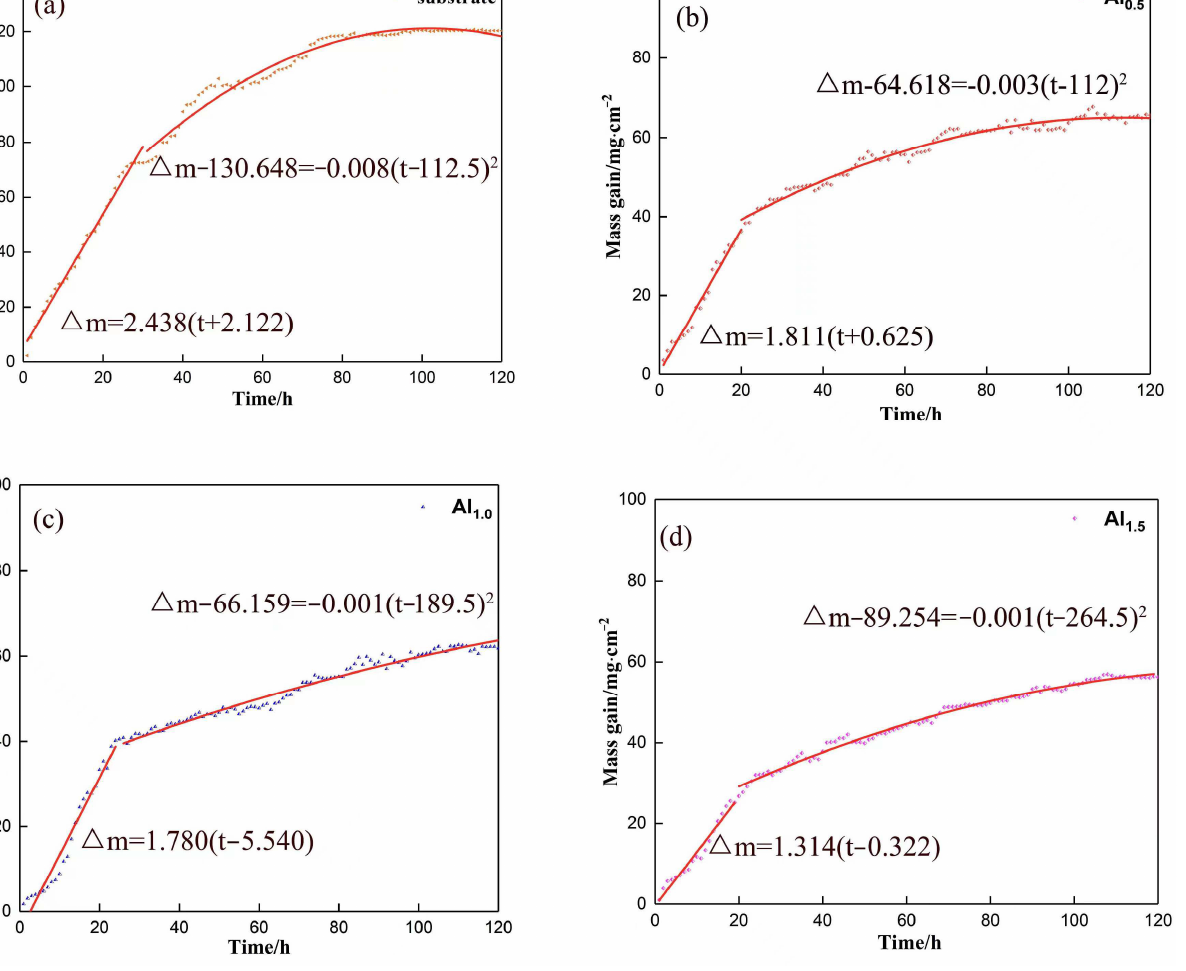
Figure 12. Oxidation mass gain fitting curves of the substrate and the coatings after exposed to 1000 °C in air for 120 h: ( a ) substrate, ( b ) Al 0.5 , ( c ) Al 1.0 and ( d ) Al 1.5 . Table 3. The calculated parameters according to the fitting curves shown in Figure 12.